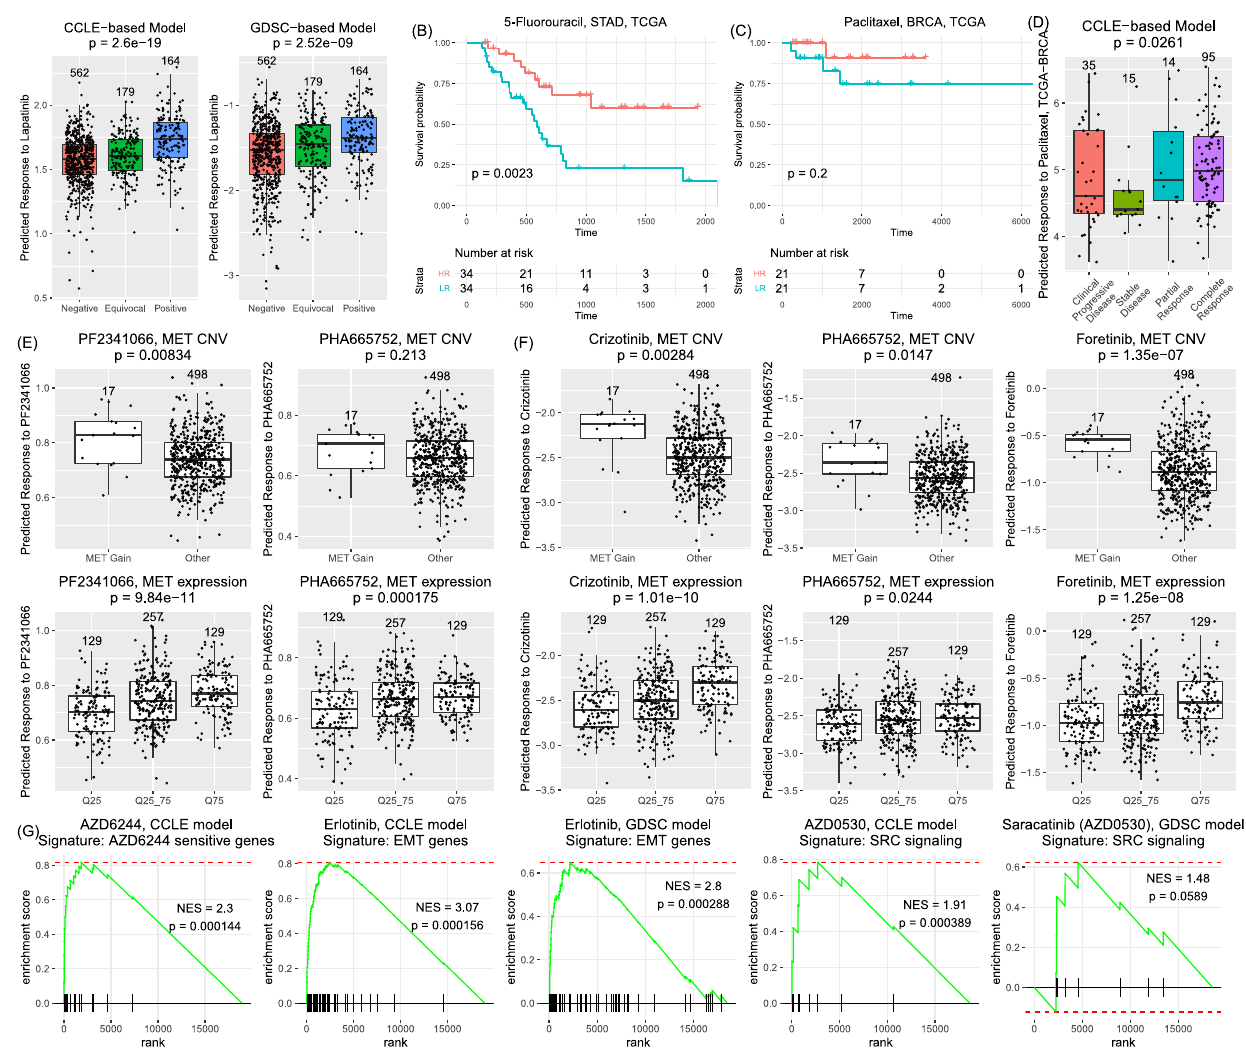
Fig. 4 Validation using TCGA data. A Comparison of predicted response to lapatinib in different subtypes of TCGA-BRCA as de fi ned using HER2 immunohistochemistry status ( n Negative = 562, n Equivocal = 179, n Positive = 164). The P value was obtained by fi tting a linear regression model with the predicted response as the outcome variable and the sample status as the predictive variable (negative samples labeled as 0, equivocal samples labeled as 1, and positive samples labeled as 2). The predictive variable is considered as numerical to measure the increasing trend among the three groups. B Survival analysis of TCGA-STAD samples treated with 5- fl uorouracil. C Survival analysis of TCGA-BRCA samples treated with paclitaxel. The P values in ( B ) and ( C ) were from a log-rank test comparing two groups of samples de fi ned by the predicted response to the corresponding drug (HR: high response, greater than the median; LR: low response). D Comparison of predicted response to Paclitaxel in TCGA-BRCA samples strati fi ed by response status. The P value was from a two-sided t test by comparing the disease group (n = 50, including samples annotated as clinical progressive disease ( n = 35) and samples as stable disease ( n = 15)) and the non-disease group (n = 109, including samples annotated as partial response ( n = 14) and samples as complete response ( n = 95)). E Association of predicted response to two MET inhibitors (PF2341066 and PHA665752) with MET ampli fi cation (top panel) or MET expression (bottom panel) using CCLE models. In the top panel, a two-sided t test was conducted to compare the predicted response in LUAD samples with MET gain ( n = 17, for both the cases of PF2341066 and PHA665752) and other LUAD samples ( n = 498, for both the cases of PF2341066 and PHA665752). In the bottom panel, samples were grouped into three groups based on MET expression: Q25 ( n = 129, the lower quartile of all samples ordered by increasing MET expression), Q25_75 ( n = 257, the middle half of samples), and Q75 ( n = 129, the upper quartile). F Association of predicted response to three MET inhibitors (crizotinib (also known as PF2341066), PHA665752, and foretinib (only tested in GDSC)], with MET ampli fi cation (top panel) or MET expression (bottom panel) using GDSC models. In the top panel, a two-sided t test was conducted for LUAD samples with MET gain ( n = 17) and other LUAD samples ( n = 498) and in the bottom panel, a linear regression model was fi t for three groups n Q25 = 129, n Q25_75 = 257, and n Q75 = 129, as in ( E ). G Validation using previously reported gene signatures to AZD6244, erlotinib, and AZD0530. The Normalized Enrichment Score (NES) and P values were obtained from Gene Set Enrichment Analysis (GSEA) implemented by the R package fgsea (1.16.0). In all boxplots ( A , D , E ), each box shows the interquartile range (IQR between Q1 and Q3) for the corresponding set. The central mark (horizontal line) shows the median and the whiskers show the rest of the distribution based on IQR (Q1 − 1.5 × IQR, Q3 + 1.5 ×